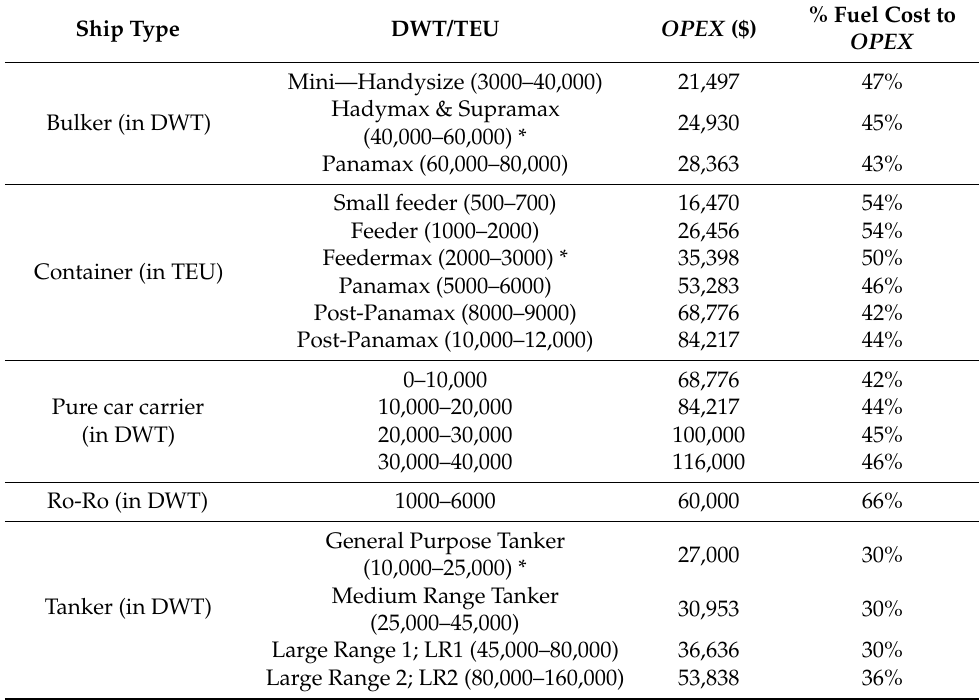
Table 1. OPEX with corresponding percentage of fuel cost to OPEX . Data processed from [21–23]. * Interpolated data by assuming a linear